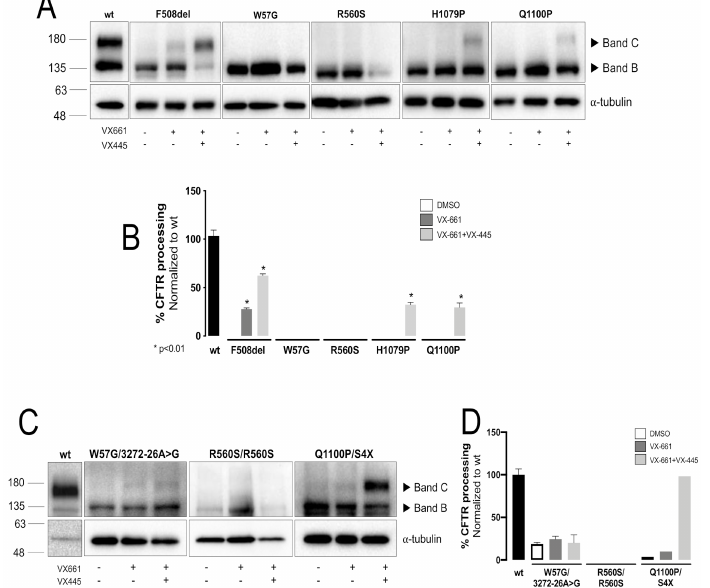
Figure 1. CFTR expression and effect of CFTR modulators. Representative WB analysis of CFBE cells ( A ) and organoids ( C ) expressing F508del-, W57G-, R560S-, H1079P- and Q1100P-CFTR, following incubation with DMSO 0.1% ( v / v ), VX-661 (5 µ M) alone or in combination with VX-445 (3 µ M) for 24h ( n = 3). ( B , D ) For each condition densitometry was used to calculate the percentage of mature CFTR (Band C/Band B + Band C). Data were normalized to the efficiency of processing of wt-CFTR and is shown as mean ± SEM. Asterisks indicate significant difference compared with DMSO ( p -value < 0.05, unpaired t test). Images were acquired using ChemiDoc XRS+ imaging system BIO-RAD and further processed by Image Lab 6.0.1 software. * p -value <